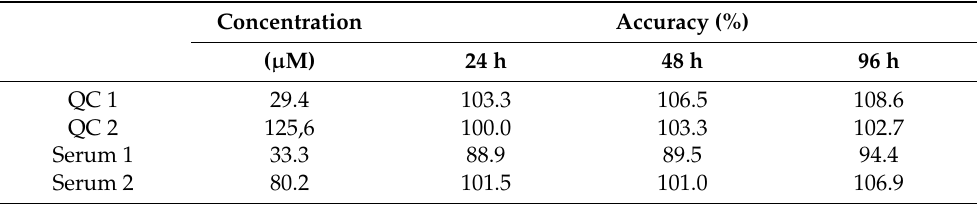
Table 4. Stability in the autosampler at ambient temperature expressed as accuracy values of 2HB after 24, 48 and 96